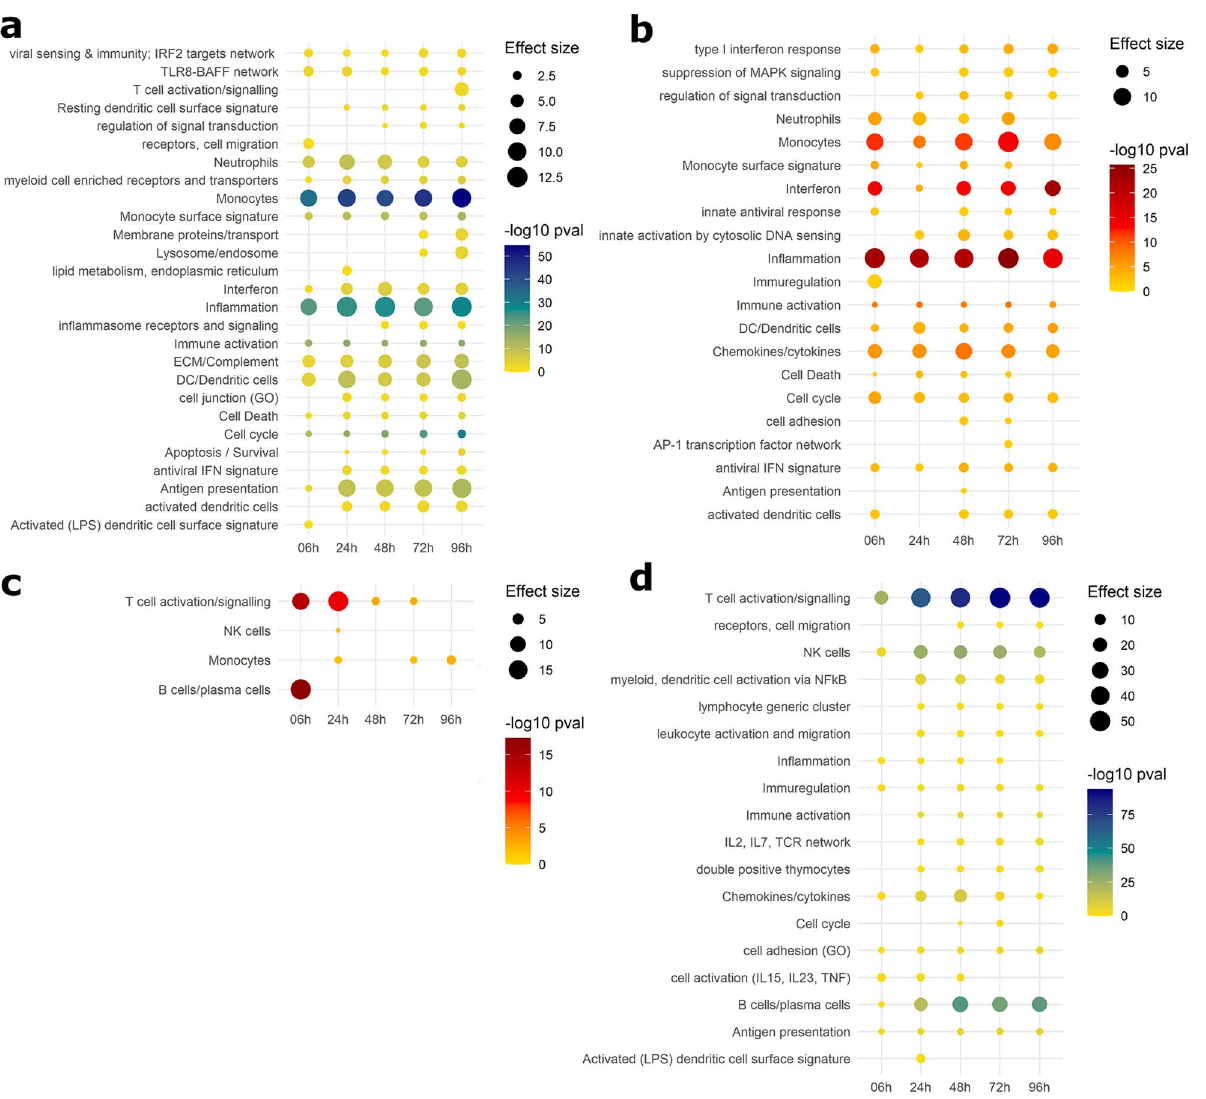
Figure 4. Dotplot of gene modules identified in adult in vivo–in vitro comparison. Gene Set Enrichment Analysis (GSEA) was performed on transcripts from the disco plot quadrants. Similar modules were summarised and plotted such that p-value of module enrichment is illustrated by the intensity of the colour (yellow–blue gradient denotes increasing significance of discordant pathways, yellow–red gradient denotes increasing significance of concordant pathways) and the effect size by the size of the dot. ( a ) Gene modules upregulated in vivo and downregulated in vitro. ( b ) Concordantly upregulated gene modules. ( c ) Concordantly downregulated gene modules. ( d ) Gene modules downregulated in vivo and upregulated in is more dominant from 48 h onwards. Paediatric in vivo–in vitro showed more concordantly downregulated modules (Fig. 3c), while adult in vivo–in vitro has a distinctly different pattern which showed many more con- cordantly upregulated modules (Fig. 3a). The largest number of modules were identified as discordantly regulated, upregulated in vitro and downregulated in vivo.